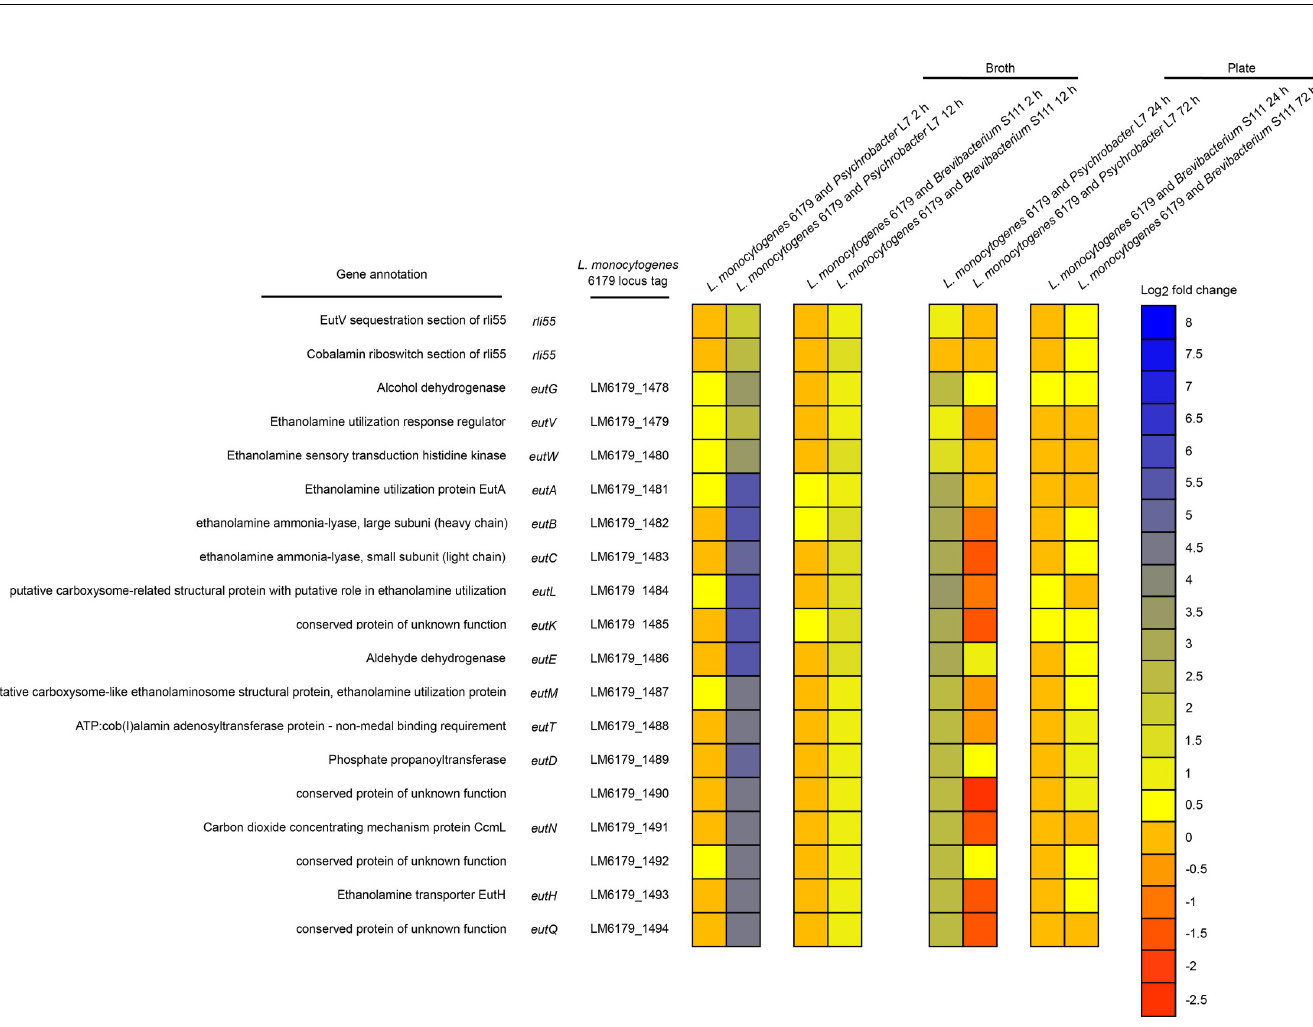
Fig 3. Heatmap showing the gene expression of the L . monocytogenes eut module, which is involved in the catabolism of ethanolamine, during co-cultivation of L . monocytogenes 6179 with Brevibacterium S111 and Psychrobacter L7 in broth and on plates. Colors represent the log2 fold change in gene expression corresponding to each co-culture condition compared to the monoculture control and the respective eut module gene. Please see S1 and S2 Tables for more details regarding gene expression patterns, including q-values and log2 fold